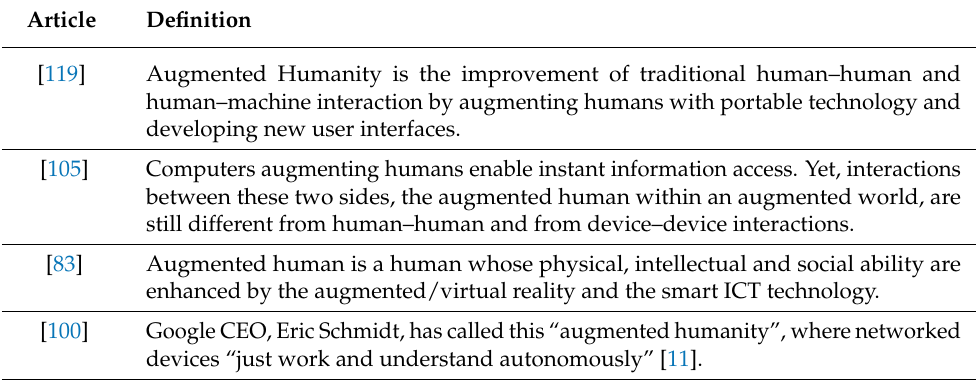
Table 5. Definitions of Augmented